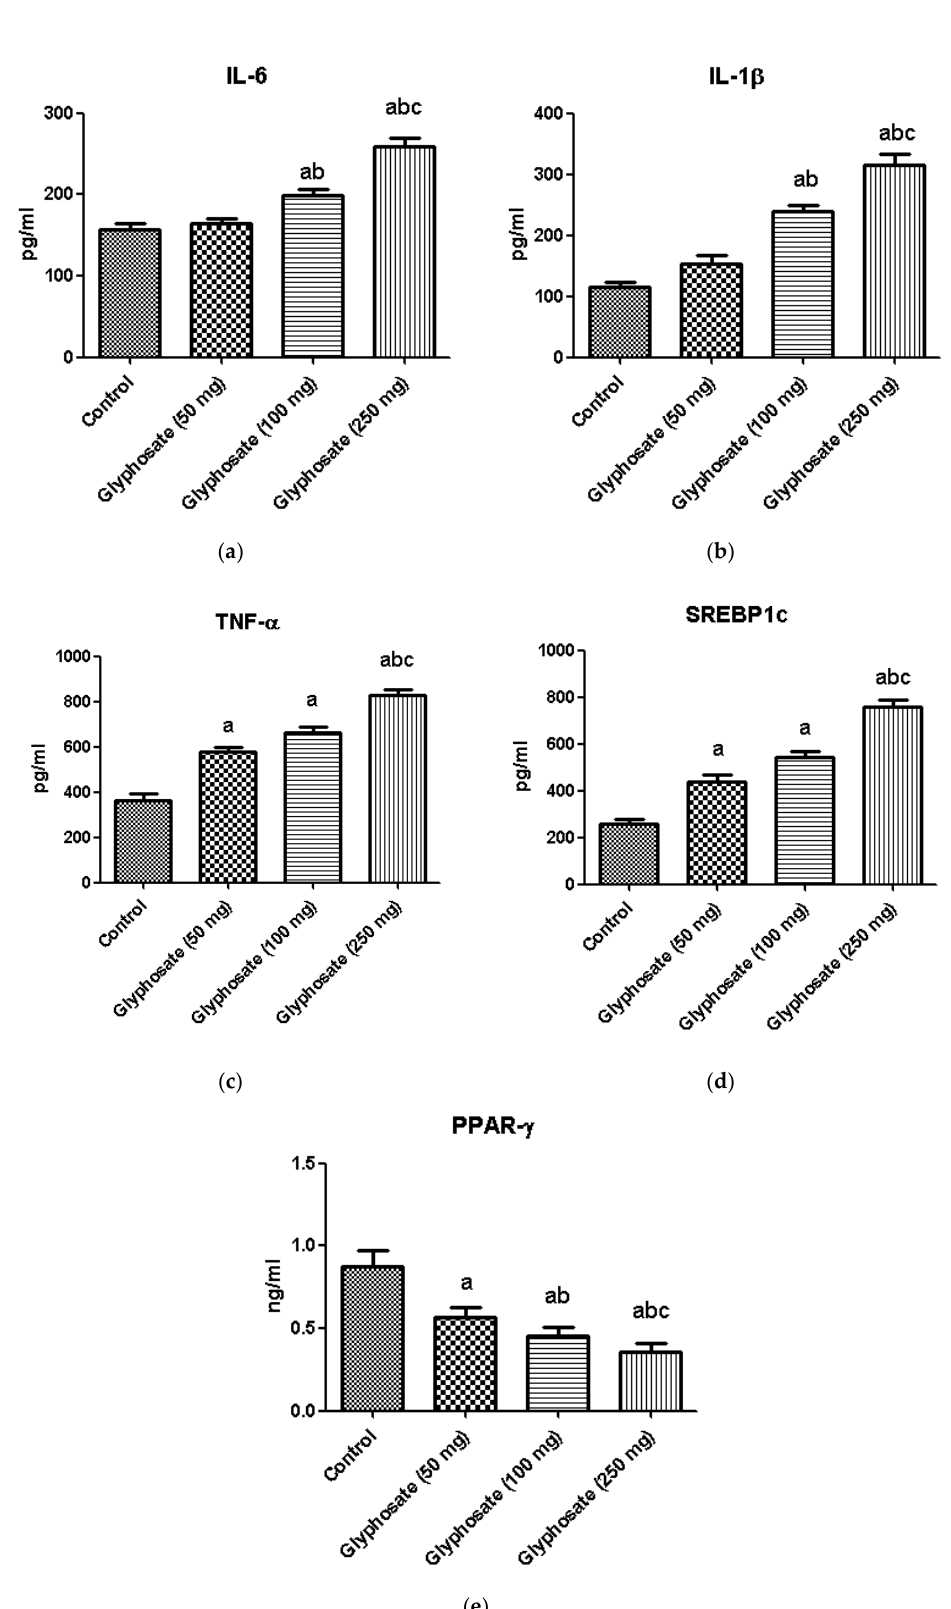
Figure 9. ( a – e ): The effect of glyphosate on protein levels of pro-inflammatory cytokines (IL-6, IL- 1β, and TNF - α) and transcriptional factors (SREBP1c and PPAR - γ) in control and glyphosate treated rats. Data were expressed as mean ± SEM where n = 6 rats for each group. Values significant at p < 0.05 were analyzed with a — control, b — glyphosate (50 mg/kg b.wt.) and c — glyphosate (100 mg/kg b.wt.).